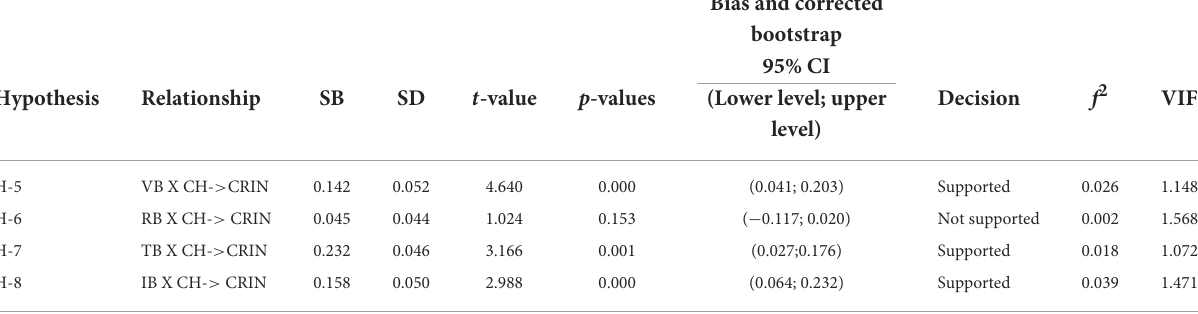
TABLE 6 Structural path analysis: the interaction effect